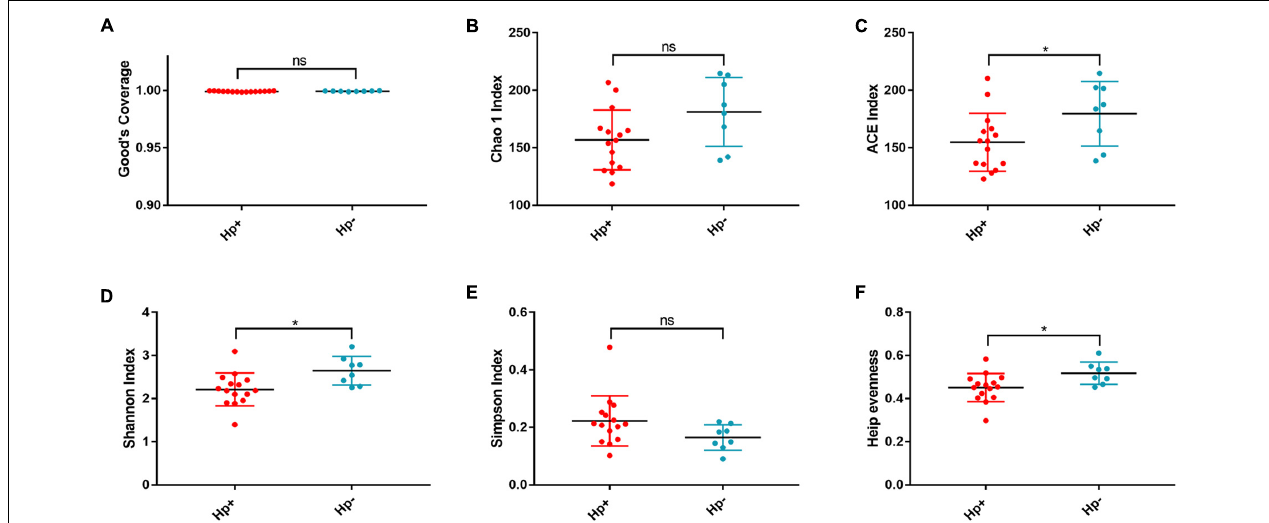
FIGURE 1 | The richness and diversity of the gastric microbiotain children with duodenal ulcer between the H. pylori -positive group and the H. pylori negative group. Good’s coverage (A) , Chao1 (B) , ACE (C) , Shanon (D) , Simpson (E) , and Heip evenness (F) were used to evaluate the overall structure of the gastric microbiota in the two stomach microtas. ns: P > 0.05; * P < 0.05. Hp+, H. pylori -positive group; Hp-, H. pylori -negative group.